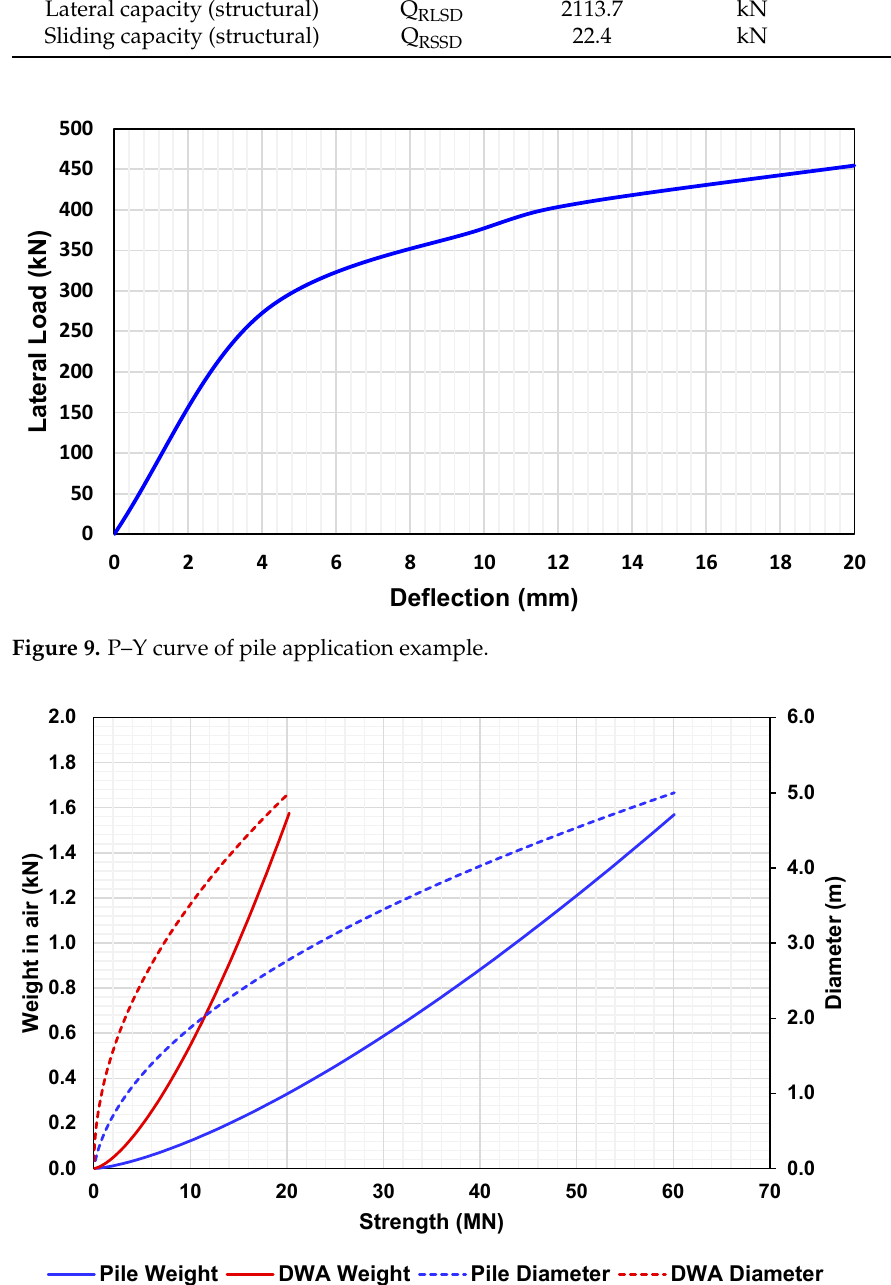
Figure 10. Comparative graph of the resistance and diameter of the anchors.